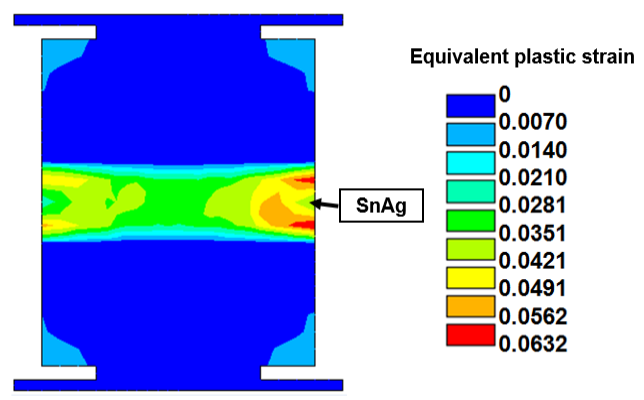
Figure 16. Contour of the equivalent plastic strain after three thermal cycles for the critical microjoint as the thicknesses of stacked chip and substrate are fixed at 385 μ m and E -value and CTE of WLUF at 7 GPa and 35 ppm/°C, respectively.